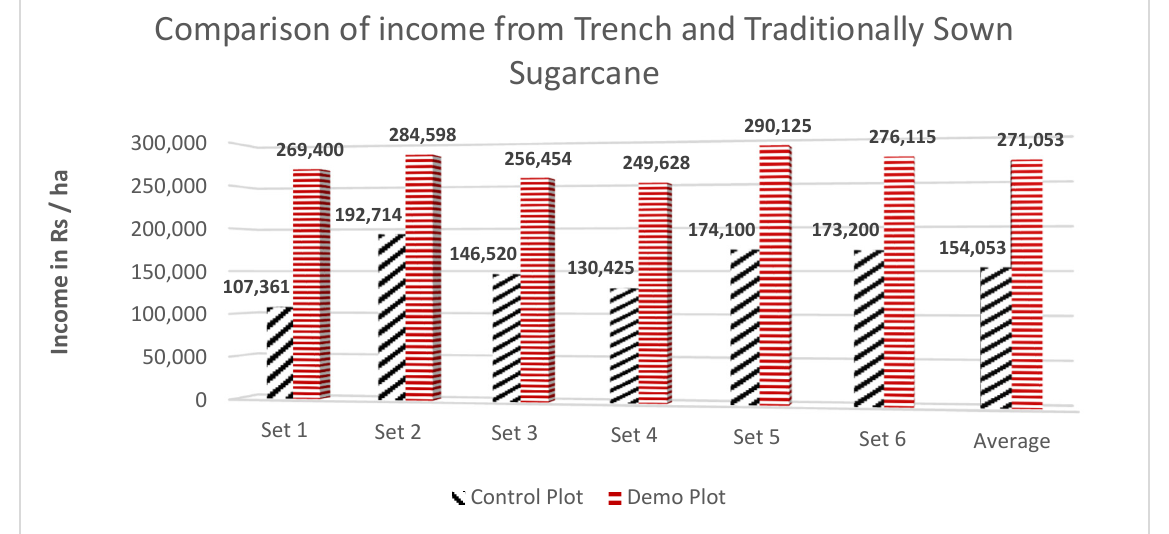
Control Plot Demo Plot Figure 8. A comparison of income per hectare (Better Management Practices including trench vs traditional method).